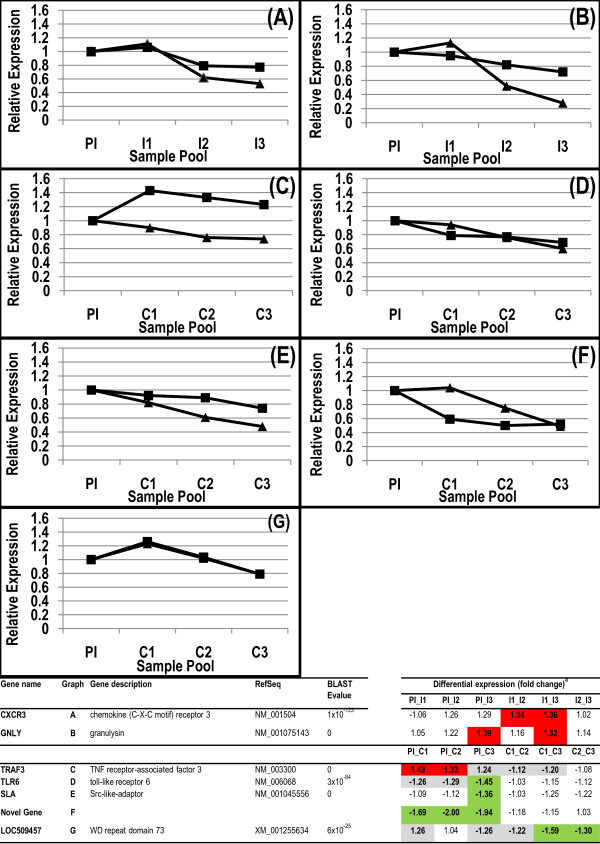
qRT-PCR validation of microarray data. (A) CXCR3, chemokine (C-X-C) receptor 3; (B) GNLY, granulysin; (C) TRAF3, TNF receptor-associated factor 3; (D) TLR6, toll-like receptor 6; (E) SLA, src-like-adaptor; (F) Novel Gene, no RefSeq; (G) LOC509457, predicted WD repeat domain 73. Gene expression assessed by qRT-PCR (black triangle) is expressed relative to the PI level. A time course of microarray data (black square) was calculated from comparative values and is expressed relative to the PI level. Comparative values used for this calculation are tabulated. aDifferential expression of genes in pooled samples PI_I1, PI_I2, PI_I3, I1_I2, I1_I3, I2_I3 or PI_C1, PI_C2, PI_C3, C1_C2, C1_C3, C2_C3 where treated as described in Methods. Down regulated genes with more than a 1.3-fold decrease (-1.3) and a P value < 0.05 are highlighted green. Up-regulated genes with > 1.3-fold increase and a P value < 0.05 are highlighted red. Genes where the change is less than a 1.3-fold decrease or increase and with a P value < 0.05 are highlighted grey. The procedure and reagents used are described in Methods.